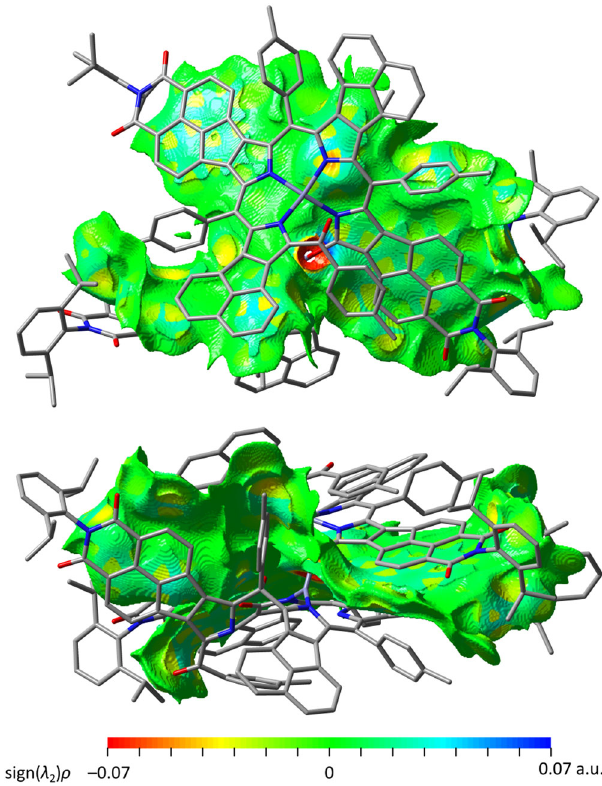
Fig. 6 Inter-subunit non-covalent interactions in 2. The calculation was performed using NCIPLOT4 31 using a DFT-optimized geometry and promolecular electron density. The s ( ρ ) isosurface (1.0 a.u.) is mapped with sign( λ 2 ) ρ , where ρ , s , and λ 2 are respectively the electron density, its reduced gradient, and the second eigenvalue of the electron-density Hessian. Attractive and repulsive interactions correspond to λ 2 < 0 and λ 30 . Top and bottom panels show the top and side 2 > 0, respectively projections of 2 ,